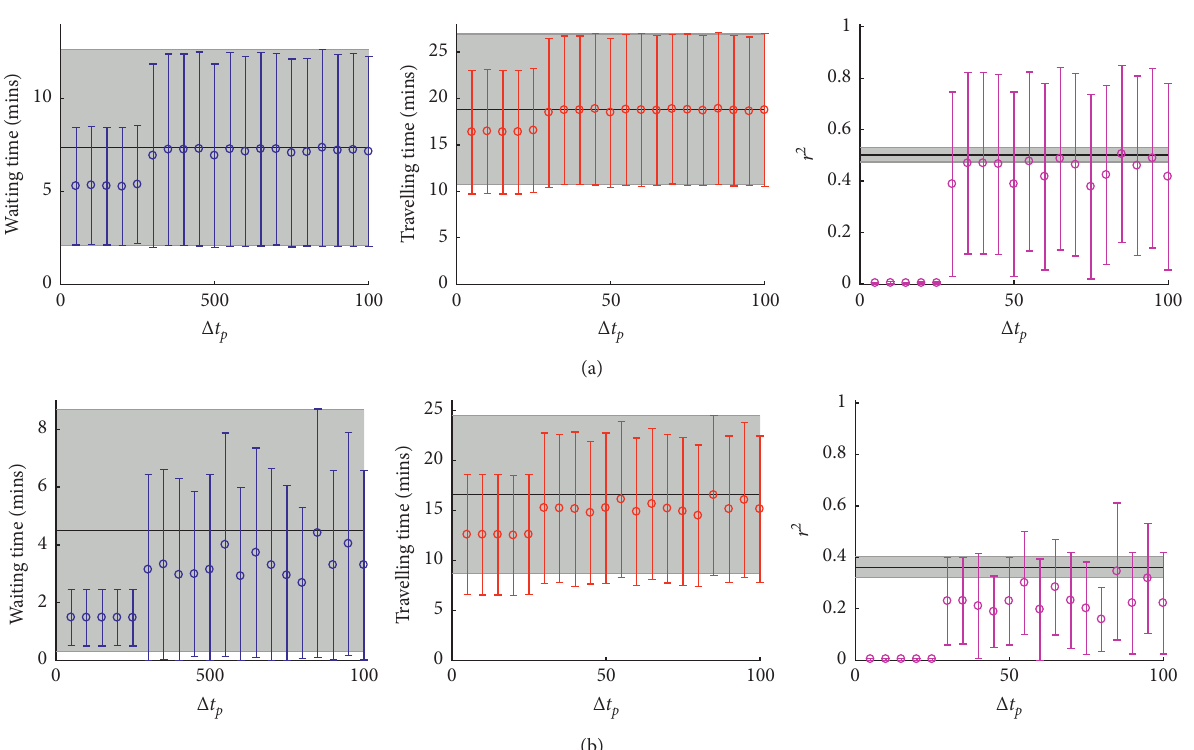
Figure 14: Results of the centralized-pulsing strategy in the two different-velocity scenarios. Each colored point represents the mean and standard deviation of the measured quantities calculated from 100 realizations of each parameter value. The black line and grey shaded area of each graph denote the mean and standard deviation of the measured quantities from a control case, which are simulation runs of the same parameter values, without any intervention strategies. (a) Centralized-pulsing strategy in lull-different. (b) Centralized-pulsing strategy in